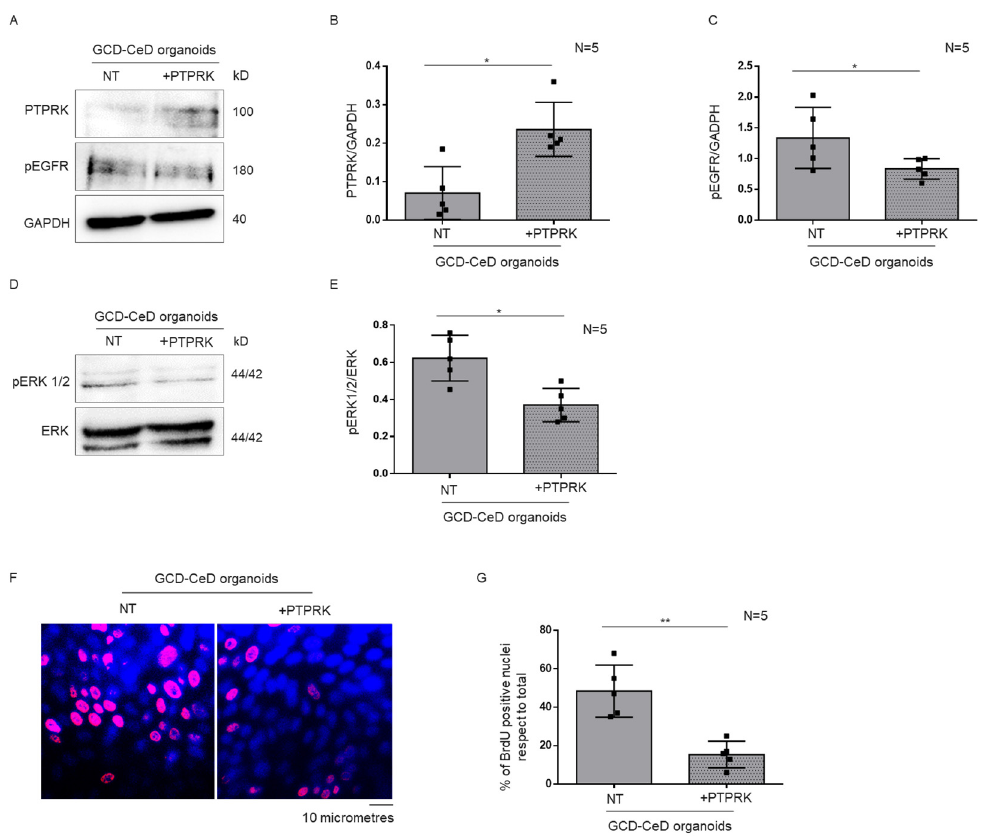
Figure 5. Overexpression of PTPRK in CeD organoids induced a decrease inpEGFR, pERK and proliferation. ( A ). Western blot analysis of total protein lysates of CeD organoids transfected and not with PTPRK. The membrane was blotted with antibodies against PTPRK, pEGFR and GAPDH as loading control. ( B , C ). Densitometric analysis of the PTPRK/GAPDH and pERK/GAPDH bands. Columns represent the mean and bars the standard deviation. Student’s t test: * = p < 0.05. ( D ). Upper lines were blotted with an antibody against pERK. Bottom lines were blotted with anti-ERK antibodies as loading control. ( E ).Densitometric analysis of the pERK/ERK bands. Columns represent the mean and bars the standard deviation. Student’s t test: *= p < 0.05. ( F ). Immunofluorescence images of intestinal organoids from GCD–CeD patients stained with anti-BrdU antibodies. Red nuclei are positive for BrdU staining. ( G ). Statistical analysis of the percentage of BrdU positive nuclei in intestinal organoids from CTR and GCD-CeD. Columns represent the mean and bars the standard deviation. Student’s t test: ** = p < 0.01.